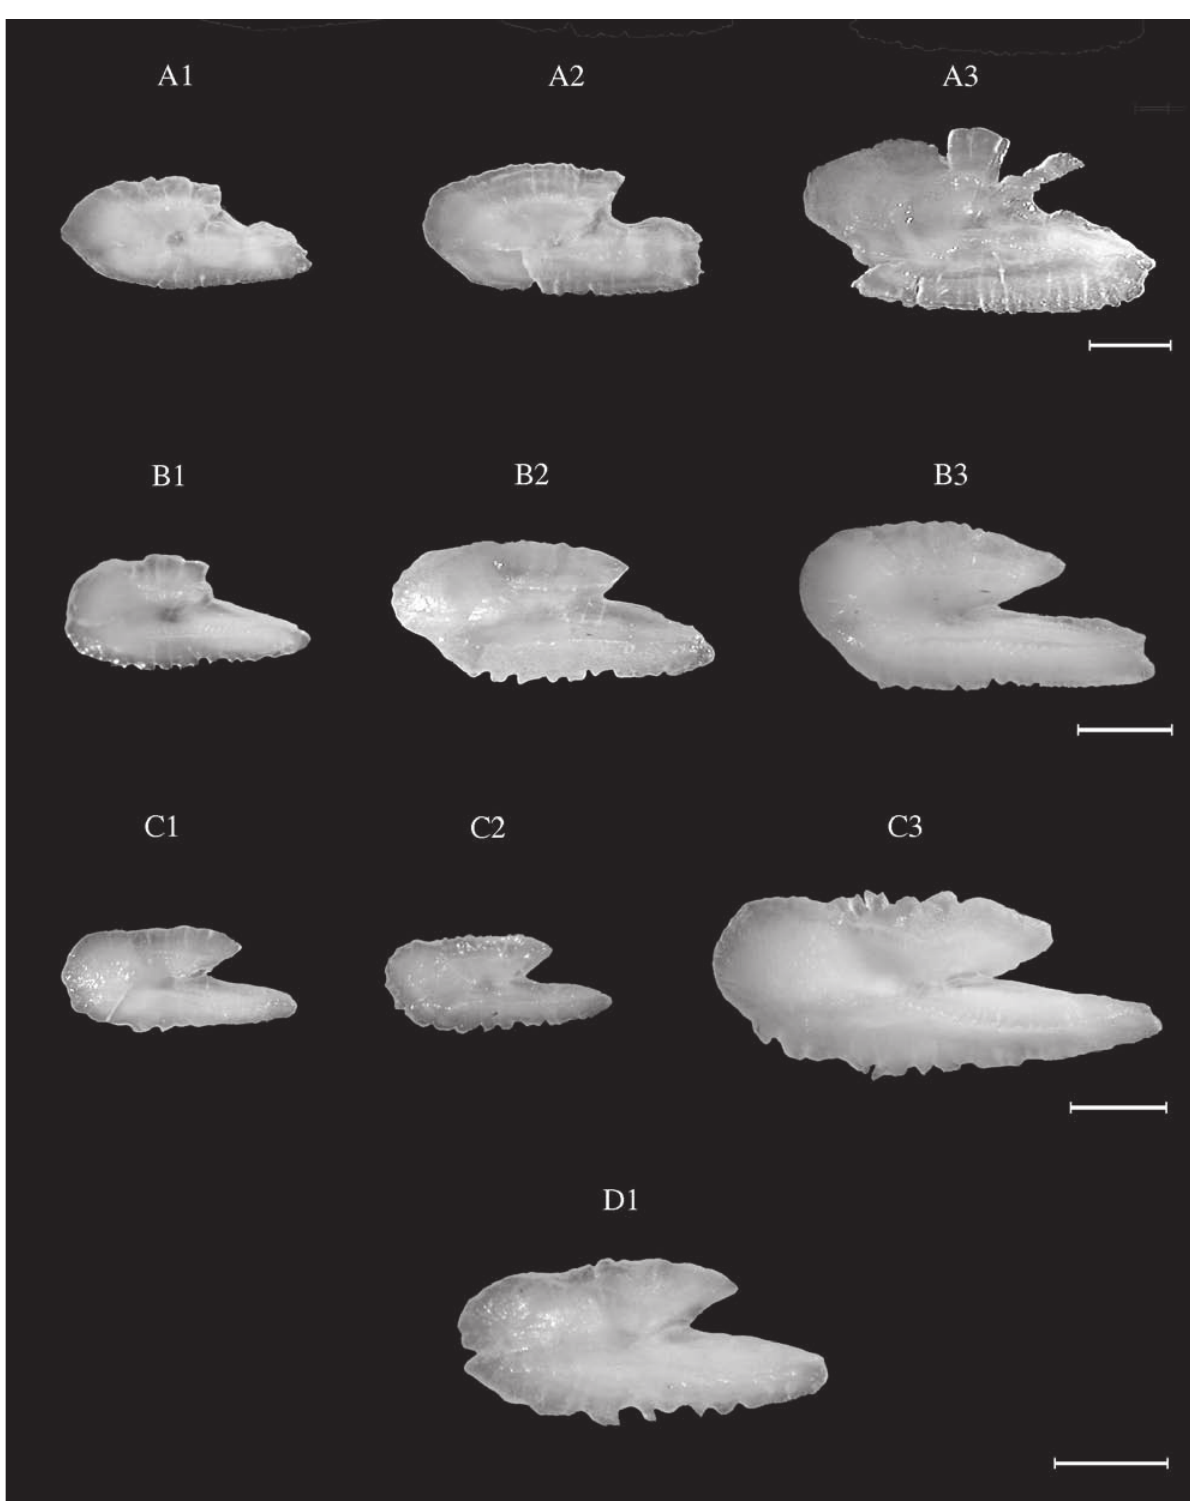
Fig. 16. – Alosa fallax. TL: A1, 21.9 cm (NEA); A2, 27.6 cm (NEA); A3, 43.5 cm (WM). Sardina pilchardus. TL: B1, 13.8 cm (CEA); B2, 17.5 cm (WM); B3, 21.4 cm (NEA). Sardinella aurita. TL: C1, 12.5 cm (WM); C2, 13.2 cm (CEA); C3, 30.0 cm (NEA). Sardinella maderensis (CEA) . TL: D1, 18.3 cm. Scale bar = 1